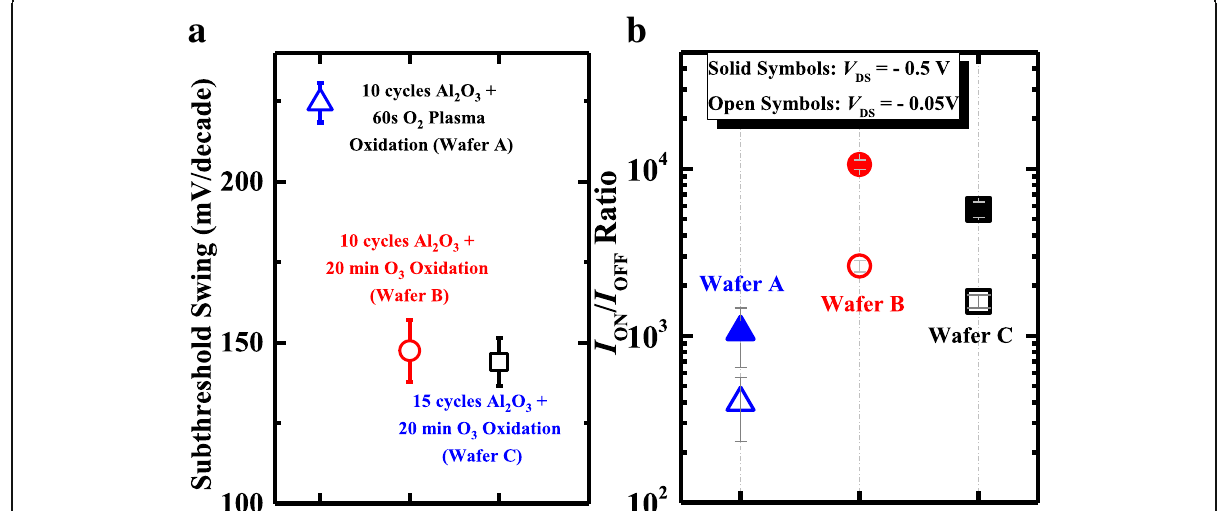
Fig. 4 Statistical plots of a SS and b I ON /I OFF ratio for Ge pMOSFETs with different passivation